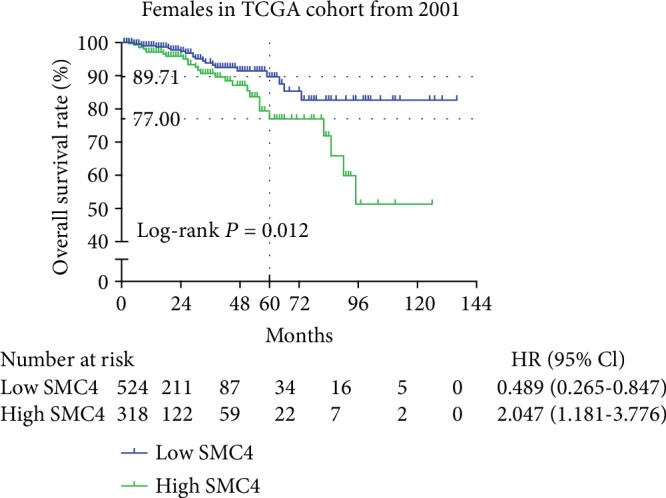
Kaplan-Meier analysis indicated that breast cancer patients with higher mRNA expression of SMC4 had worse survival in TCGA dataset (P = 0.012).